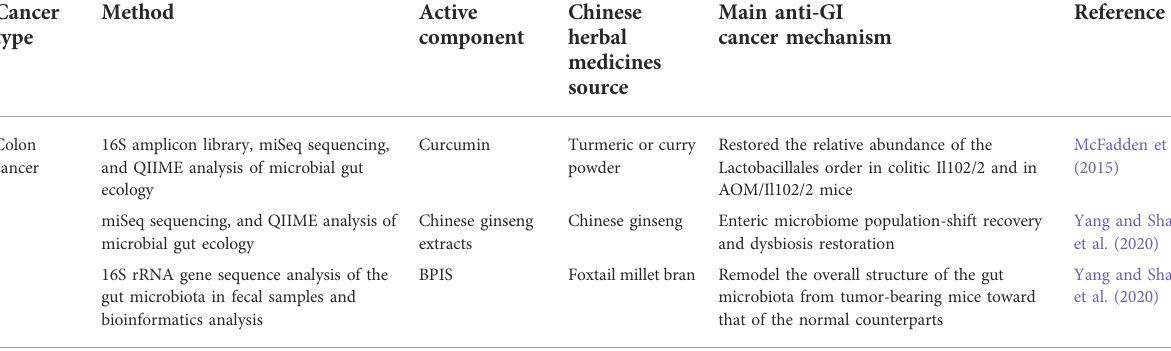
TABLE 5 Applications of microbiomics approaches to study Chinese herbal medicines in GI cancers.